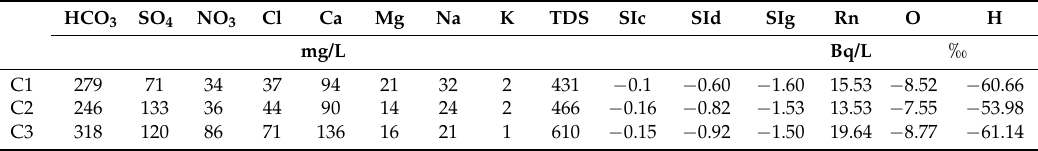
Table 4. The statistical results of clusters for groundwater samples from October.